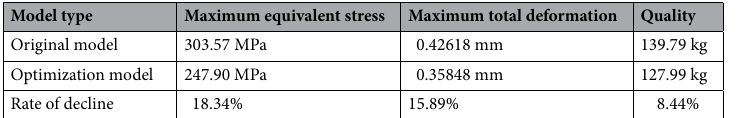
Table 7. Comparison table of box optimization